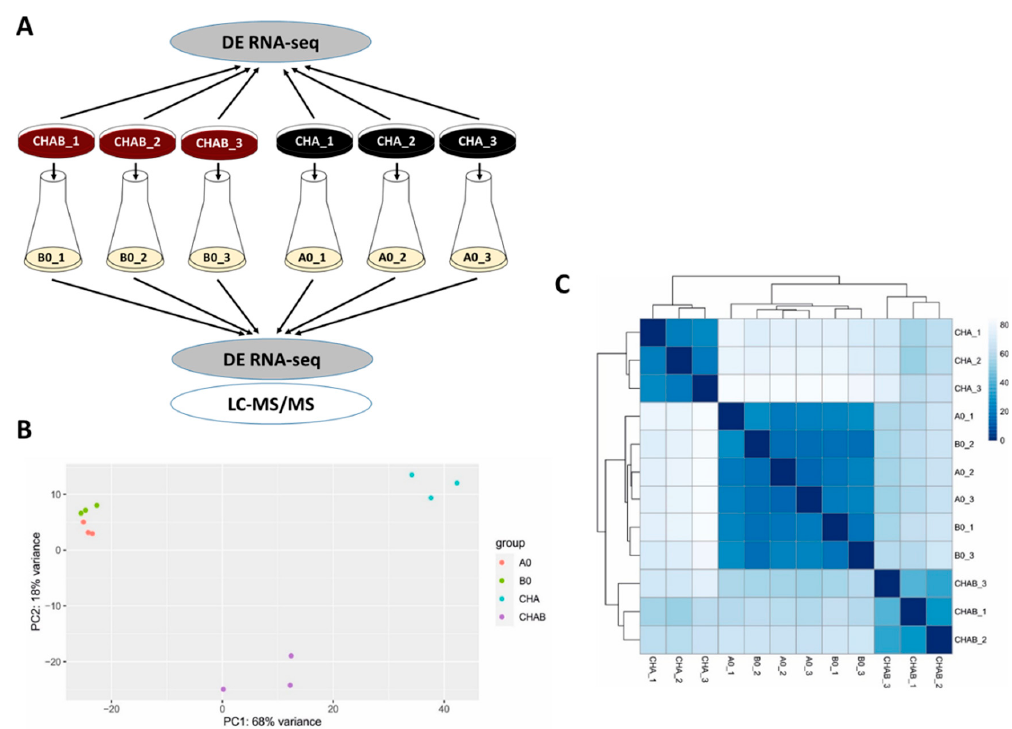
Figure 2. Direct exposure to blood rewires the global expression profiles in B. pertussis . ( A ) Scheme depicting the experi- mental layout and origin of samples used for transcriptomic and proteomic profiling of cells grown in the presence (CHAB and B0 samples) or absence (CHA and A0 samples) of blood. Cells were either harvested directly from CHAB and CHA plates for RNA-seq analysis or were used to inoculate B0 and A0 liquid cultures, respectively. Cells from liquid cultures were used for RNA-seq (pellets) and LC–MS/MS (supernatants) analyses. ( B ) Principal component analysis of samples based on RNA-seq analysis. ( C ) Heatmap showing hierarchical clustering of RNA-seq data by Euclidian sample-to-sample distances (represented by the color